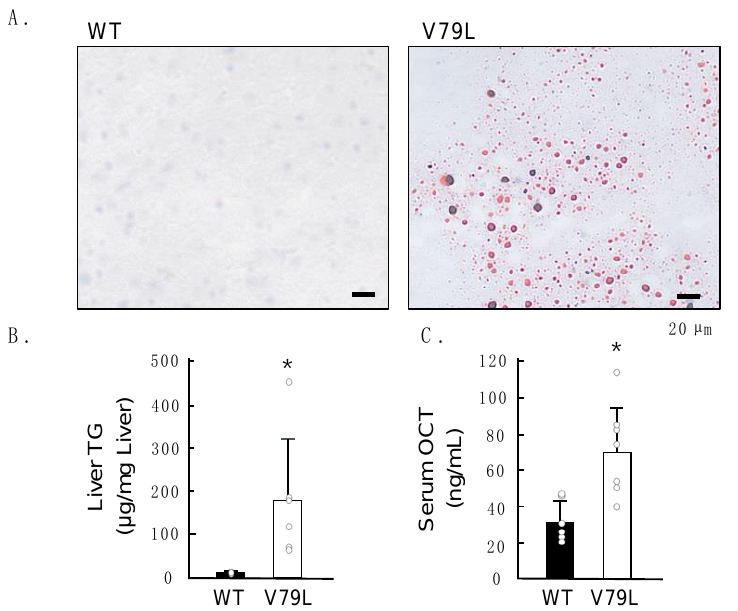
Figure 2. Fatty liver with mitochondrial injury in IARS1 V79L mice. ( A ) Oil-red-O-stained liver sections from B6 and IARS1 V79L mice and ( B ) quantification of the liver triglyceride and ( C ) serum ornithine carbamoyltransferase levels in B6 ( n = 6) and IARS1 V79L ( n = 6) mice; * denotes p < 0.05.